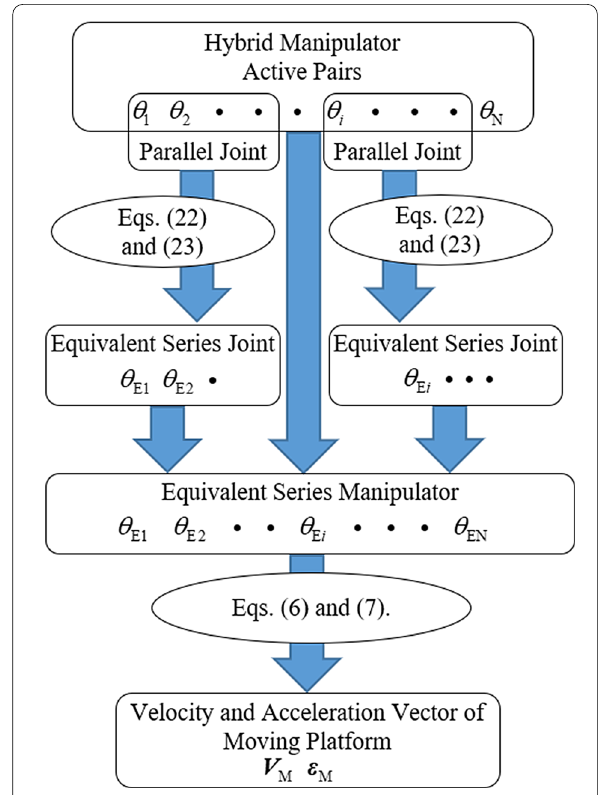
Figure 3 Forward kinematics analysis of hybrid